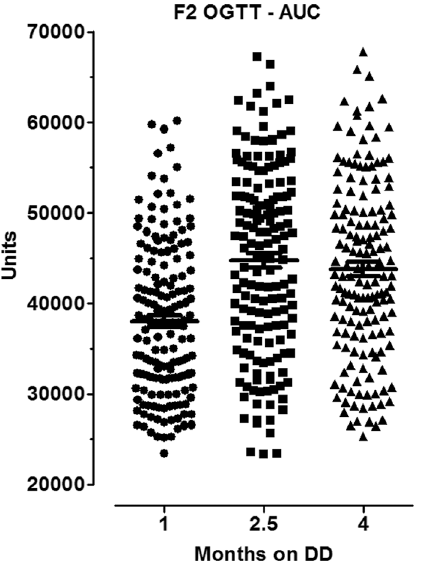
Figure 1. Results of the oral glucose tolerance test (OGTT) in CDs/y (n = 6) and SBN/y (n = 6) after 1, 2.5 and 4 months of feeding with diabetogenic diet (DD). The upper pan- els (A, B and C) represent average blood glucose levels at set times of the OGTT (mean ± standard error of the mean). The lower panels (D, E and F) represent the calculated area under the curve (AUC) of glucose levels during the OGTT by the respective time points.